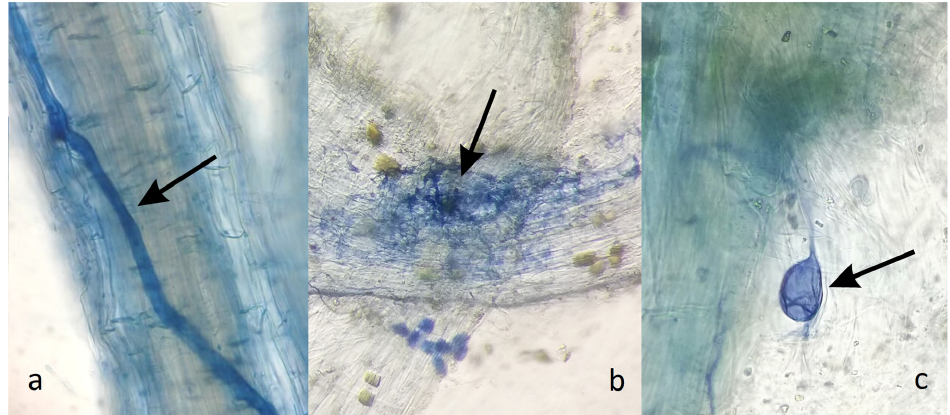
Figure 2. Characteristic cellular structures of arbuscular mycorrhizal fungi stained with trypan blue solution. ( a ) Roots colonized by hyphae (black arrow) and ( b ) roots colonized by arbuscules (black arrow) and ( c ) vesicles (black arrow). Similar structures were observed in samples from both cultivation